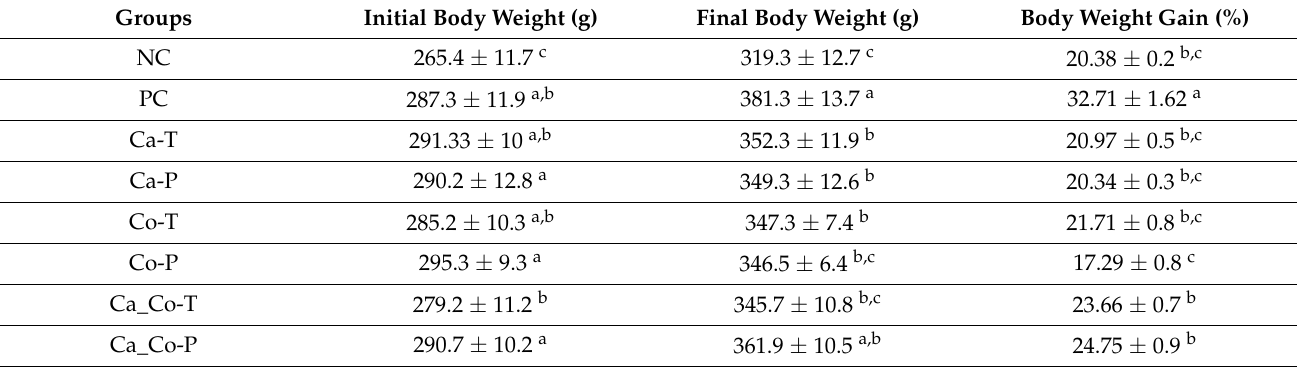
Table 3. Effect of different fermented milks on some growth parameters in hypercholesterolemic